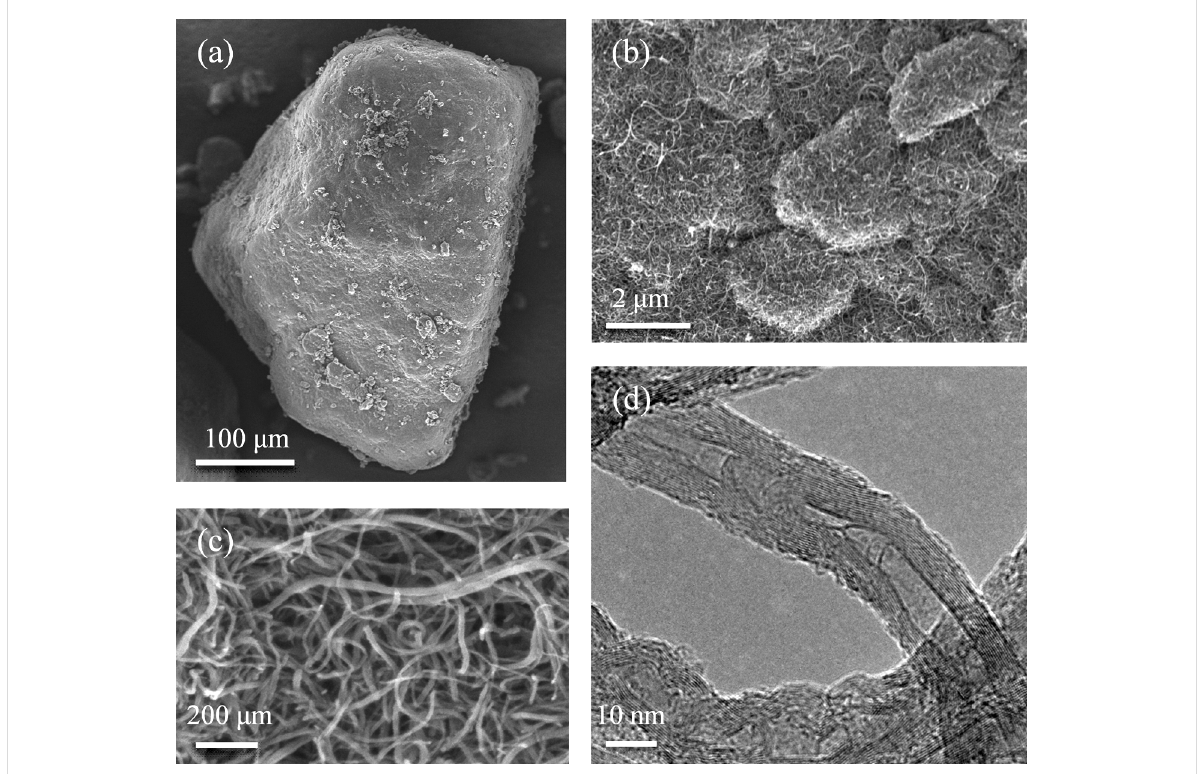
Figure 1: a) SEM overview of a Baytubes agglomerated pellet; b, c) SEM details of the MWCNTs; d) TEM detail of typical MWCNTs.